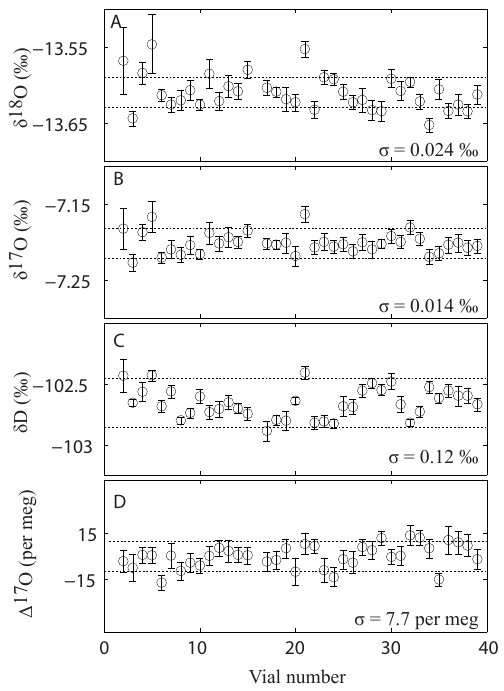
Figure 5. Comparison of the sensitivity of isotope ratio measure- ments on the L2140- i CRDS analyzer to the water-vapor mixing Figure 4. Isotope ratios from repeated measurements of 2mL vials ratio using peak amplitude vs. integrated absorption. Note that a of identical water, using integrated absorption on the L2140- i . (A) mixing ratio of 20mmolmol − 1 is reported by the instrument soft- δ 18 O, (B) δ 17 O, (C) δ D, and (D) 1 17 O. Each dot represents the av- ware as a concentration (20000ppm). (A) δ 18 O, (B) δ 17 O and (C) erage of ten 1.8µL injections from one vial; the vertical error bars √ 1 17 n ) of the n = 10 individual injections. show the standard error ( σ/ The standard deviation of all vial means ( σ ) is given in each panel. Horizontal dashed lines are shown for reference at ± 0.02‰ for δ 18 O and δ 17 O, at ± 0.2‰ for δ D, and at ± 10 per meg for 1 17 O. The experiment shown took about 60h. No drift corrections or other post-measurement adjustments were made to the raw data.